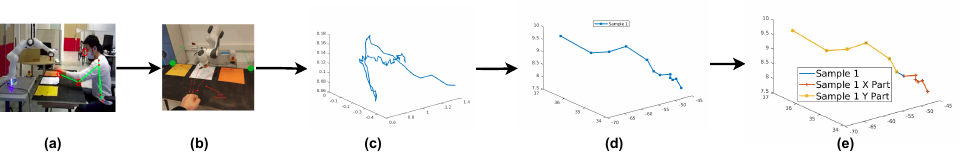
Figure 5. Demonstration of the environment for dataset generation, ( a ) shows the person working in shared environment with a cobot, ( b ) shows the possible goals on which the hand should be moving, ( c ) shows one sample hand motion trajectory generated over one minute, ( d ) shows the sub-trajectory over 12 observations, and ( e ) shows the trajectory divided into two sequences ( x for training and y for